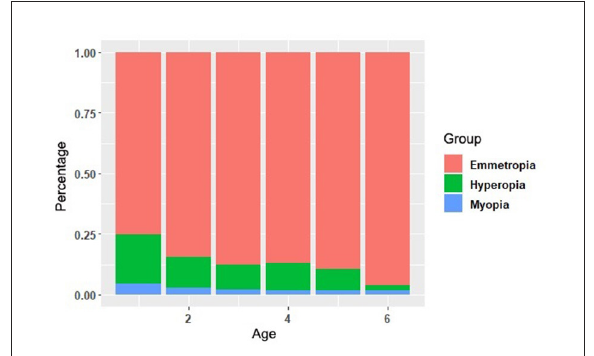
FIGURE3 The proportion of emmetropia, hyperopia, and myopia.